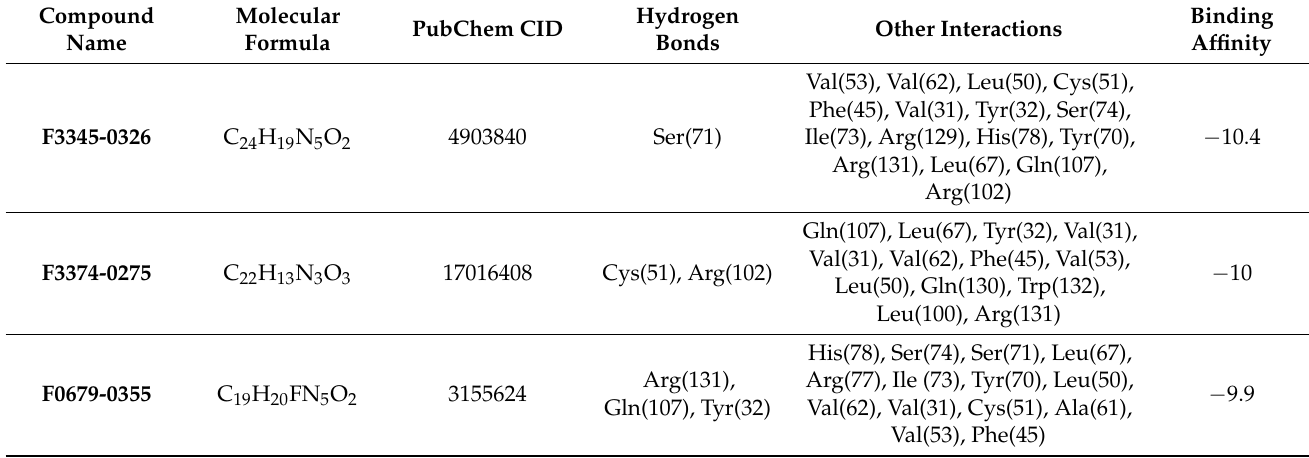
Table 1. Molecular Docking result analysis of the top three